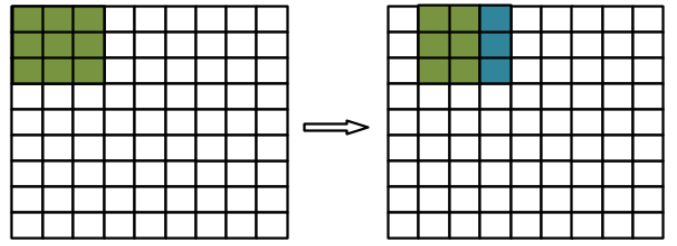
Figure 10. Shift operation of image